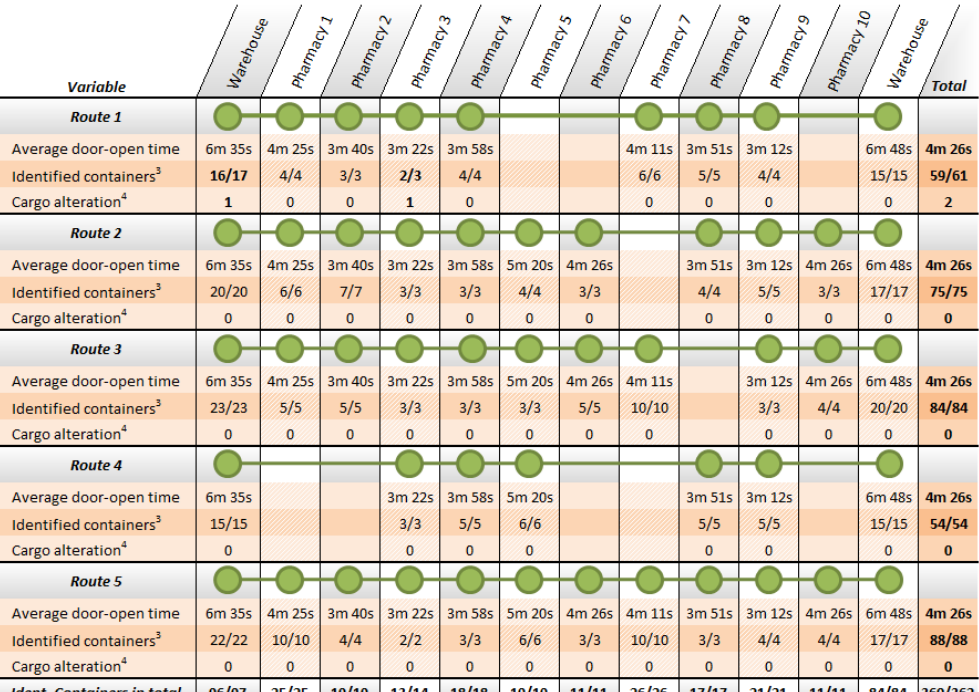
Figure 15. Results of the second phase of system validation: the identification system.